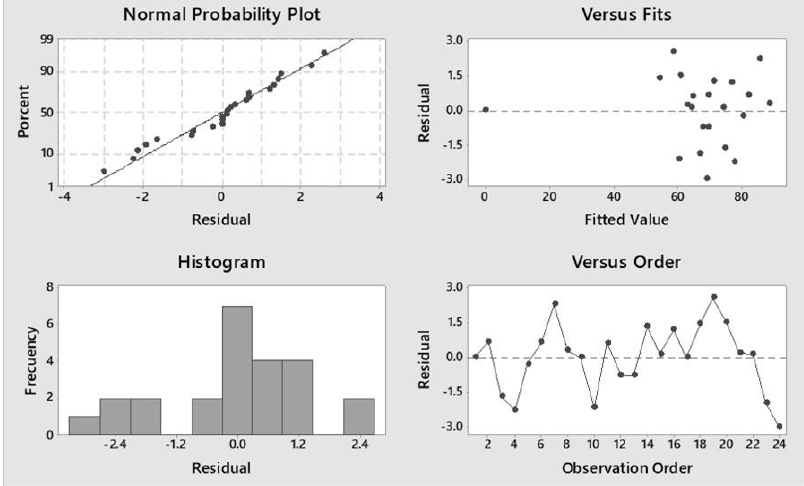
Figure 13. Residual plots for copper dissolution.